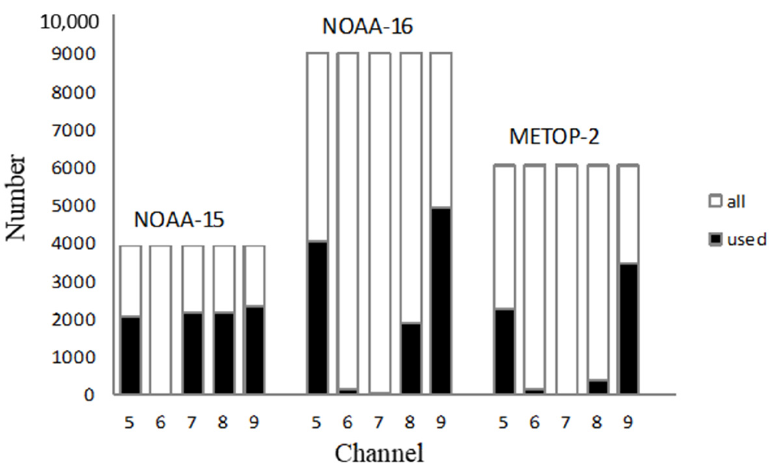
Figure 1. The number of radiance observations for different channels of different instruments used in the experiments in Section 3 and 4.